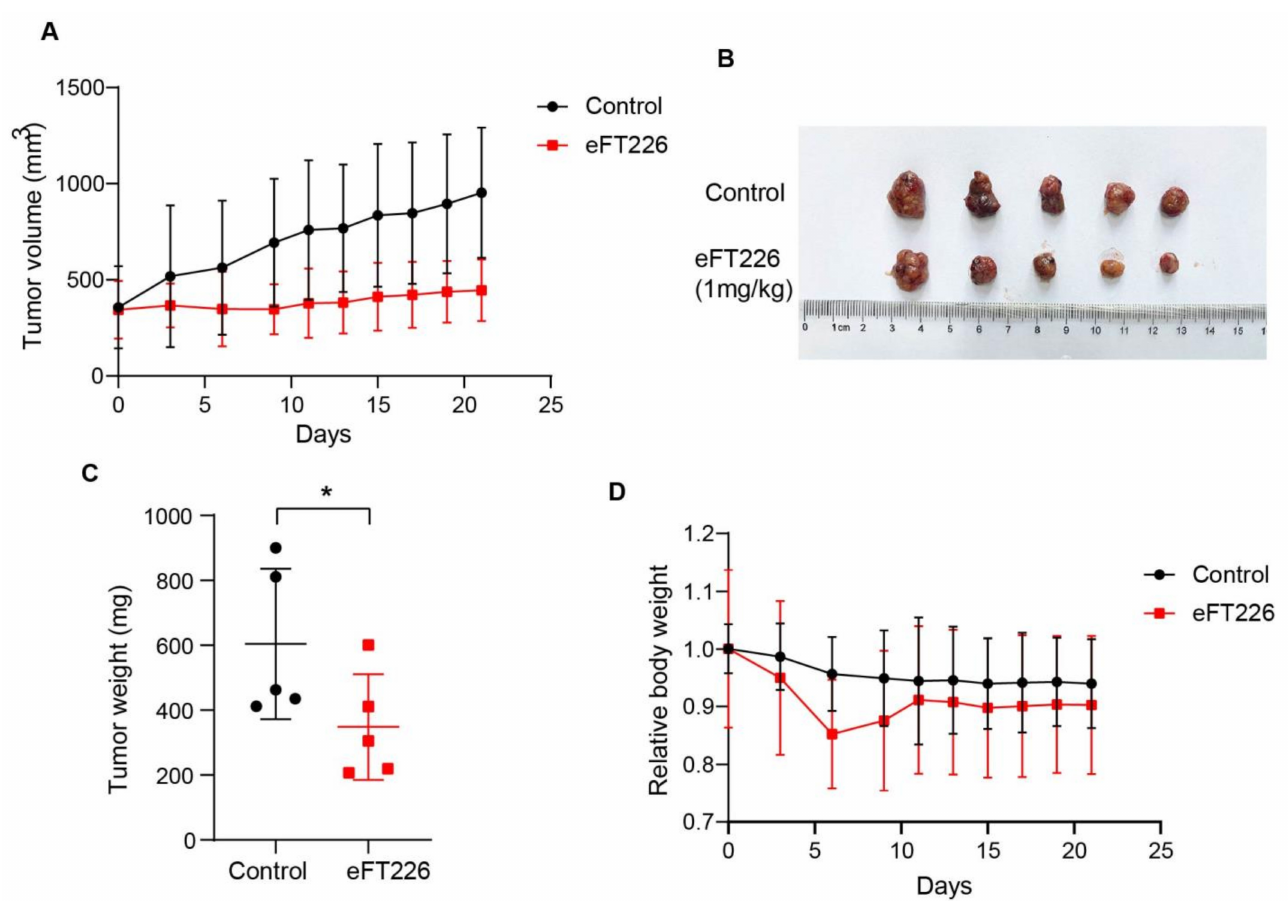
Figure 9. eFT226 suppresses PLC/PRF/5 tumor growth. Nude mice bearing subcutaneous tumors derived from PLC/PRF/5 cells were i.p. administered with vehicle control (5% dextrose in water) (n = 5) or eFT226 (1 mg/kg, 1 times/week) (n = 5) for 3 weeks. Tumor volumes ( A ), photographs of tumors ( B ), tumor weights ( C ), and mouse body weights ( D ) are shown. Error bars represent mean ± SD. * p <